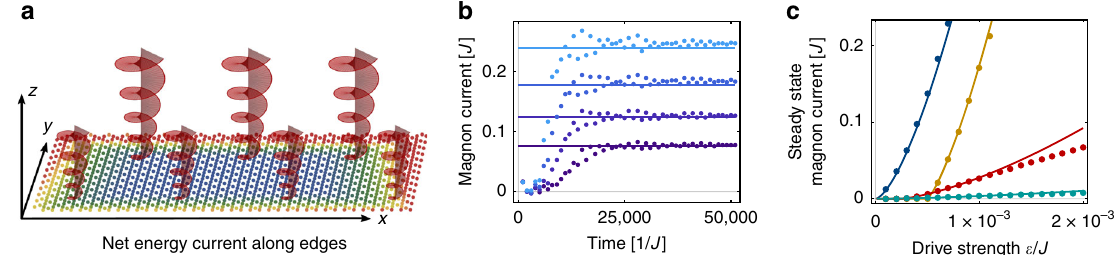
Fig. 3 Driving and resulting edge current. a The two-dimensional kagome lattice ferromagnet is driven by an electromagnetic fi eld perpendicular to the kagome plane. To observe the driven Hall effect (DHE), the fi eld is applied with a linear gradient along y , which leads to a temperature difference along x . Colour gradient from blue to red indicates increasing temperature. b The current as function of time. The shades of blue from dark to bright correspond to E ¼ f 3 ; 4 ; 5 ; 6 g ´ 10 (cid:2) 4 J , respectively. The straight line is the theoretical prediction for the steady-state value (10). From the equation of motion one can (cid:2) 1 log ðE = η Þ . c The steady-state particle current plotted against the drive strength E . The estimate the time to reach the steady state to be of order t eq (cid:9) E solid lines correspond to the theoretical formula Eq. (10), whereas the dots are calculated numerically. In {blue, yellow, red, turquoise} we show ( γ , η ) = {(1, 0.1), (100, 0.1), (50, 1), (10, 10)} × 10 − 5 J . We see that Eq. (10) agrees well with the numerically calculated steady-state current. The yellow, red, and turquoise curves have kinks at 2 E ¼ γ , which mark the onset of instability. The clear deviation occurs once bulk modes become unstable, in which case our approximations break down and system ceases to remain close to the ground state. All unspeci fi ed parameters are as in Fig 1., except for W =